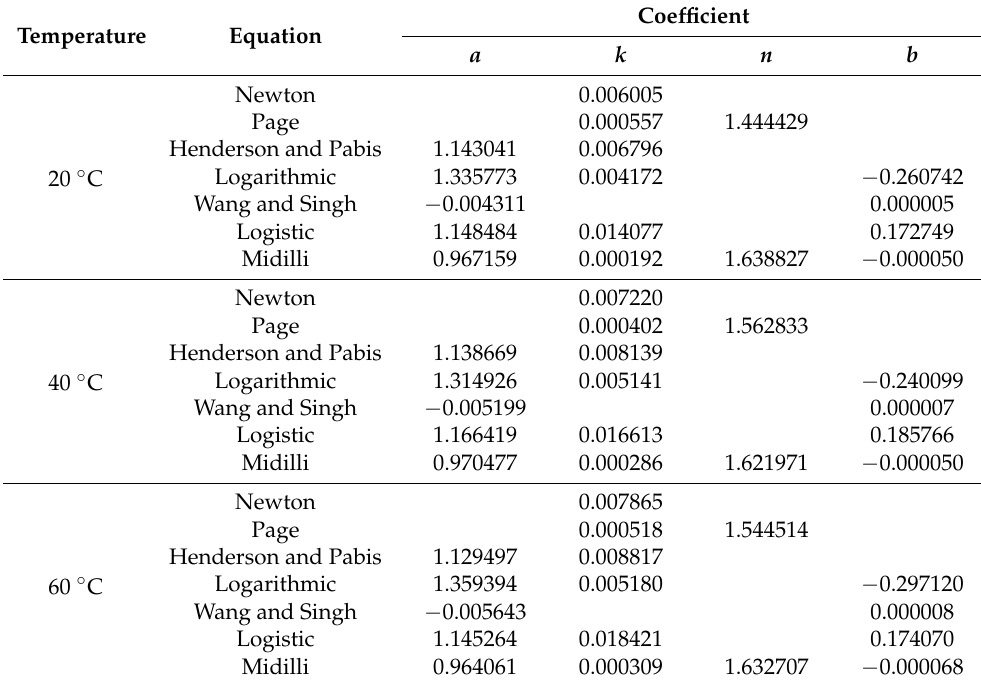
Table 5. Coefficient values in the models describing the freeze-drying of strawberry pulp. Temperature